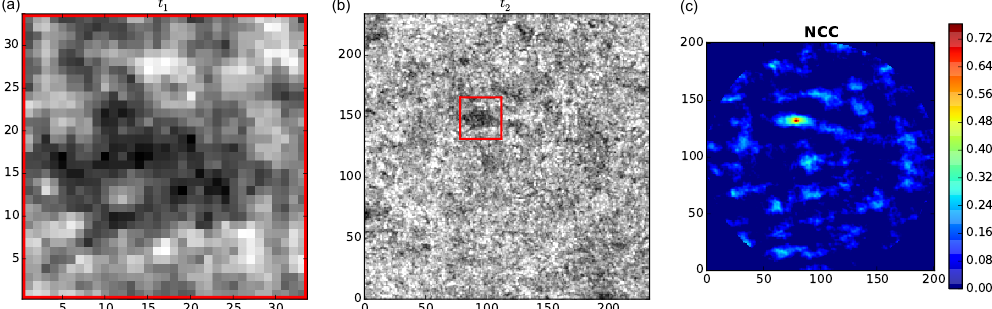
Figure 7. Pattern matching using initial drift estimate from feature tracking: The small template t 1 (a) around the point of interest on SAR 1 is rotated from α − β to α + β and matched with the large template t 2 (b) from SAR 2 , which has its centre at the estimated end position x 2 , y 2 . The right contour plot shows the normalised cross-correlation matrix NCC of the rotation β ∗ that provided the highest maximum cross- correlation coefficient MCC. The estimated end position x 2 , y 2 of this example has to be adjusted by d x =− 21 pixels, d y = 32 pixels to fit with the location of MCC = 0.71. Rotation adjustment β ∗ was found got be 3 ◦ . NB x and y axes represent pixel coordinates.